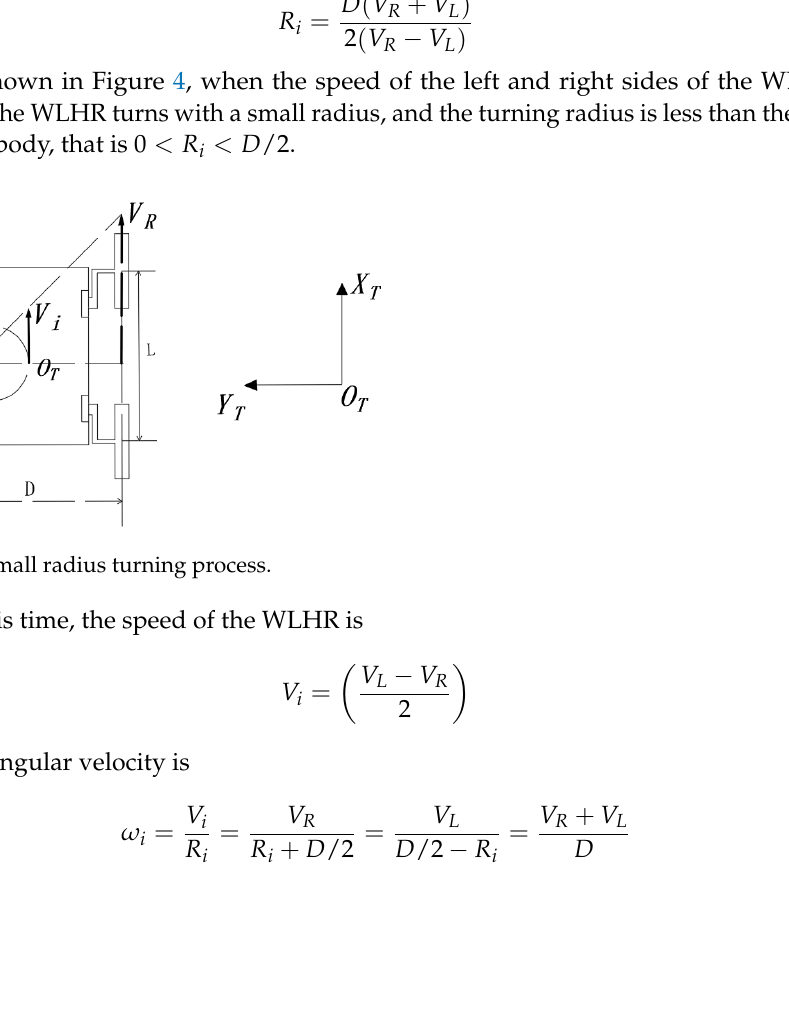
Figure 5. Kinematics model. From the knowledge of kinematics, the velocity can be obtained by deriving the displacement, and the angular velocity can be obtained by deriving the velocity. The kinematics equation derived from the rotation matrix can be obtained as follows: